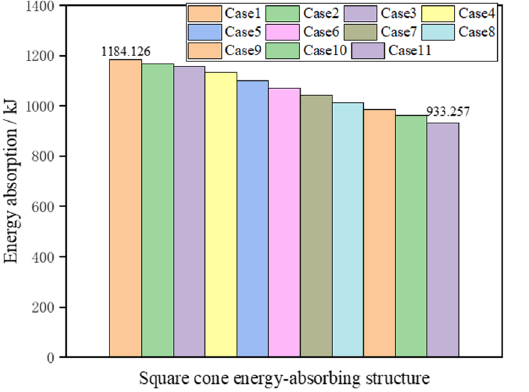
Figure 18. Influence of the slope of platform force changes on square cone energy-absorbing structure.